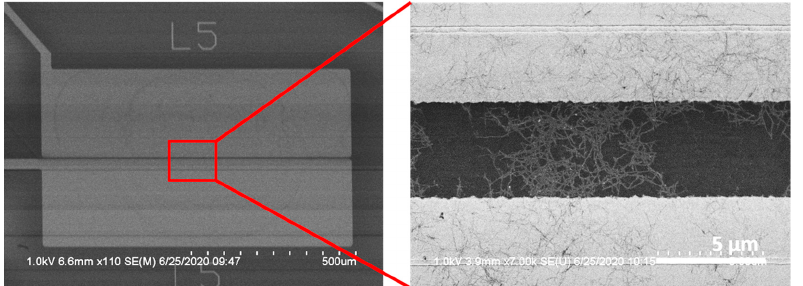
Figure A1. Scanning electron microscope (SEM) image of pristine CNTFET between source and drain electrode. CNT network is randomly deposited on Si 3 N 4 layer between Pt electrodes by ink- jet printing process. Channel length of shown device is 5 µm.